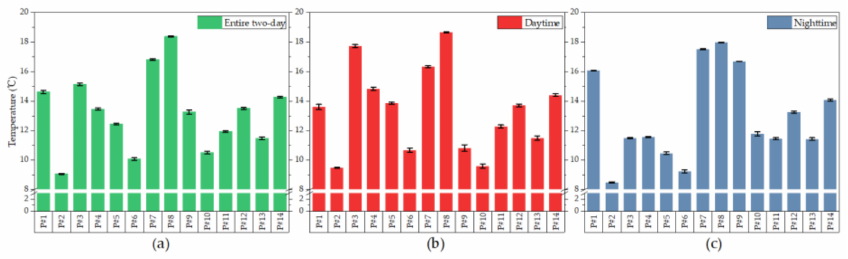
Figure 6. Personal mean experienced temperature with standard error. Personal mean experienced temperature ( a ) over the entire two-day period, ( b ) during daytime, and ( c ) during nighttime.